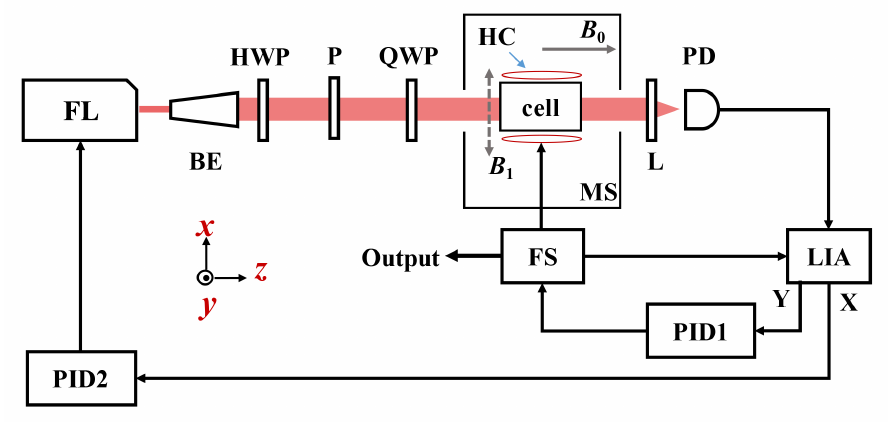
Figure 1. Schematic diagram of the experiment setup. FL, fiber laser; BE, beam expander; HWP, half-wave plate; P, polarizer; QWP, quarter-wave plate; L, lens; HC, Helmholtz coils; PD, photodiode; LIA, lock-in amplifier; PID, Proportion-Integration-Differentiation controller; FS, frequency synthesizer; MS, magnetic